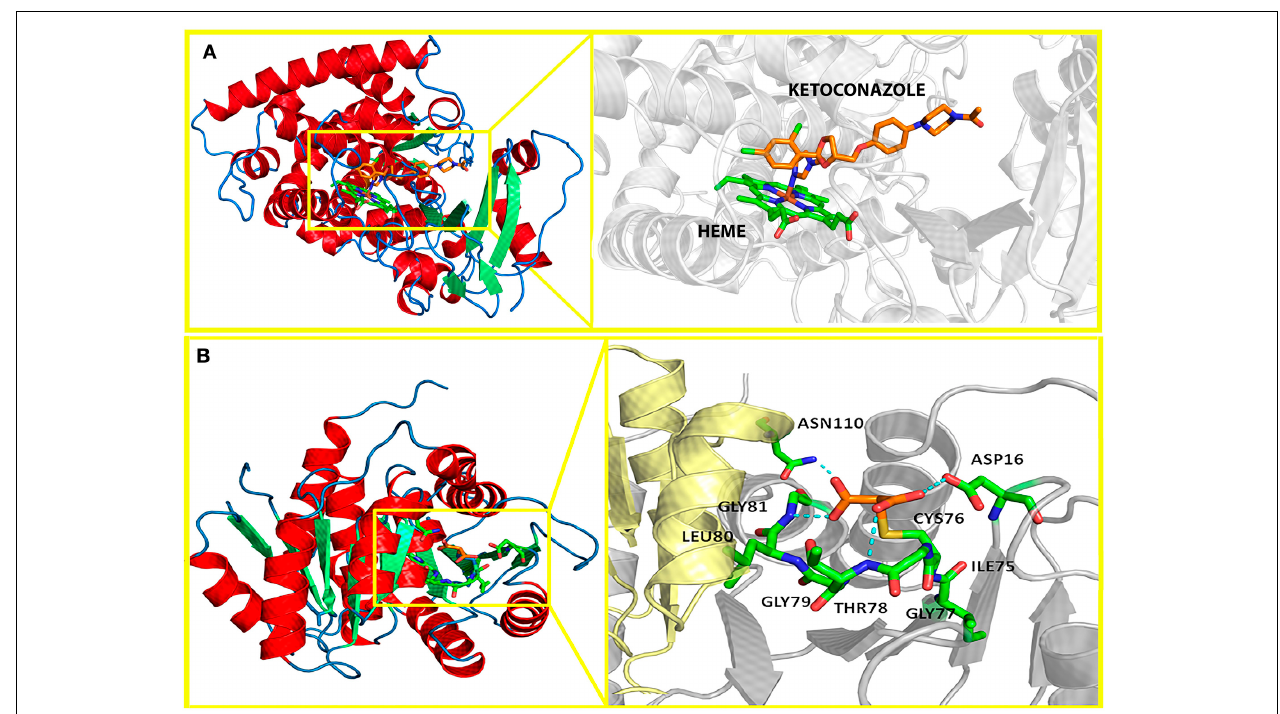
FIGURE 3 | Current and potential targets for marine products, respectively. (A) Lanosterol 14- α -demethylase (CYP51), an essential enzyme in fungal sterol biosynthesis. The crystal of human CYP51 available in the Protein databank (PDB: 3LD6) allows to identify the inhibitor (ketoconazole) binding to the heme group.